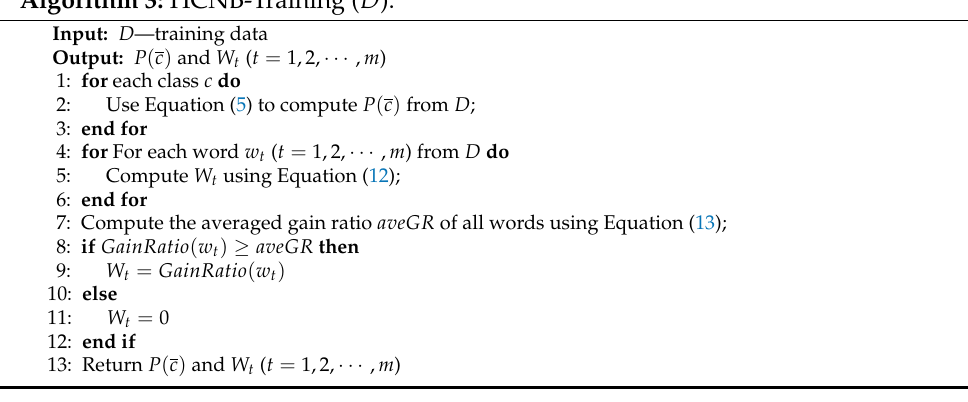
Algorithm 3: HCNB-Training ( D ).